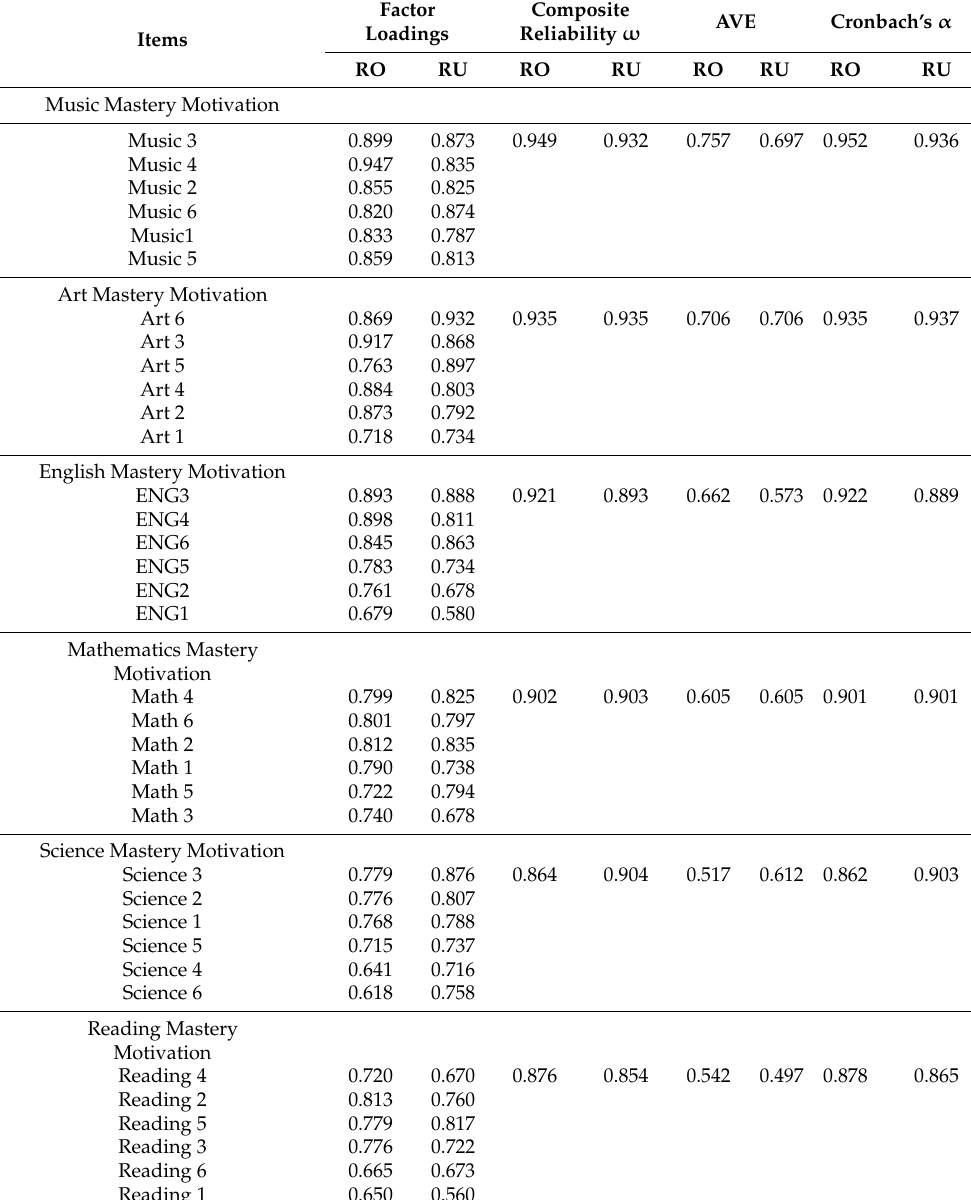
Table 3. Factor Loadings, Composite Reliability, AVE, and Cronbach’s Alphas for the Romanian and Russian versions of the